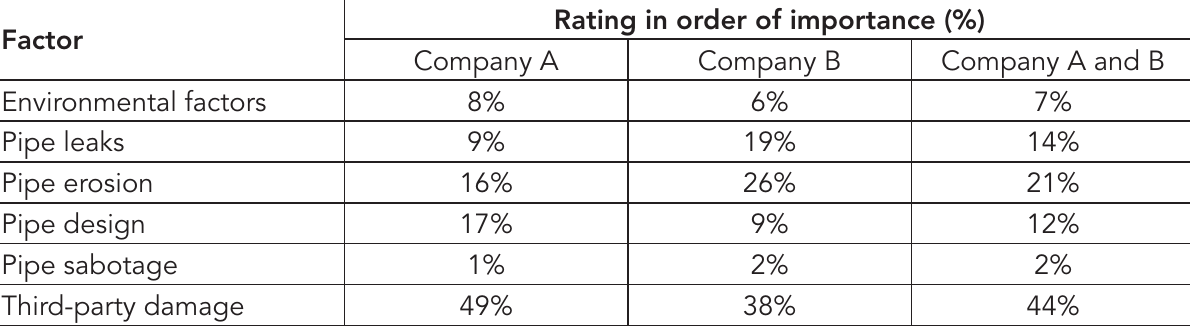
Table 2: Perceived risks by pipeline